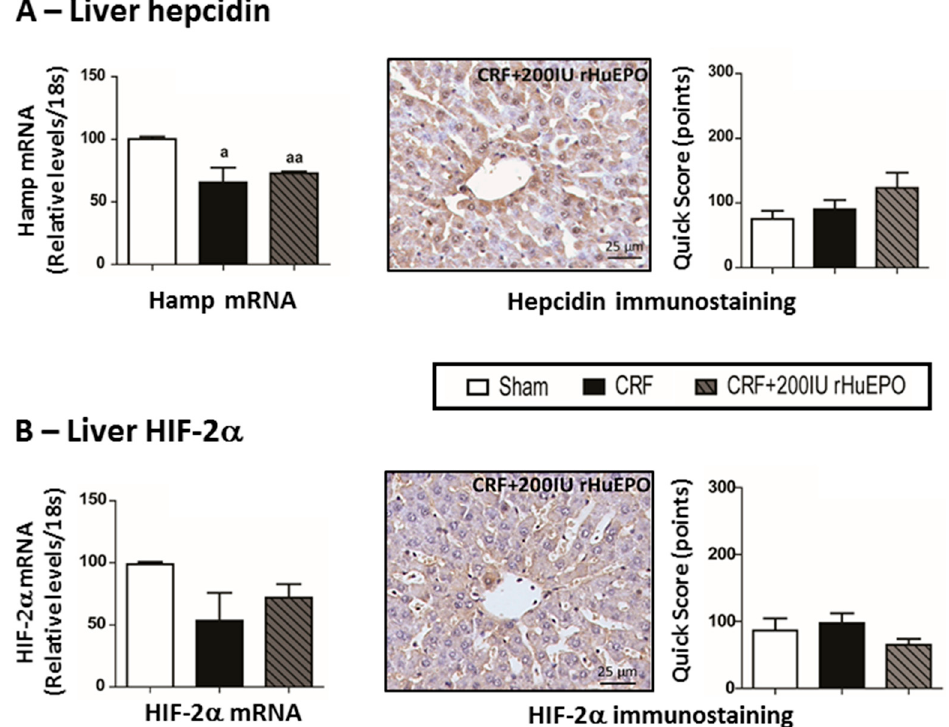
Figure 4. Liver hepcidin ( A ) and HIF2 α ( B ) expression of mRNA and protein (immunohistochemical staining). Original magnification ×400. Results are presented as mean ± SEM (seven rats per group): a: p < 0.05; and aa: p < 0.01 vs. Sham.